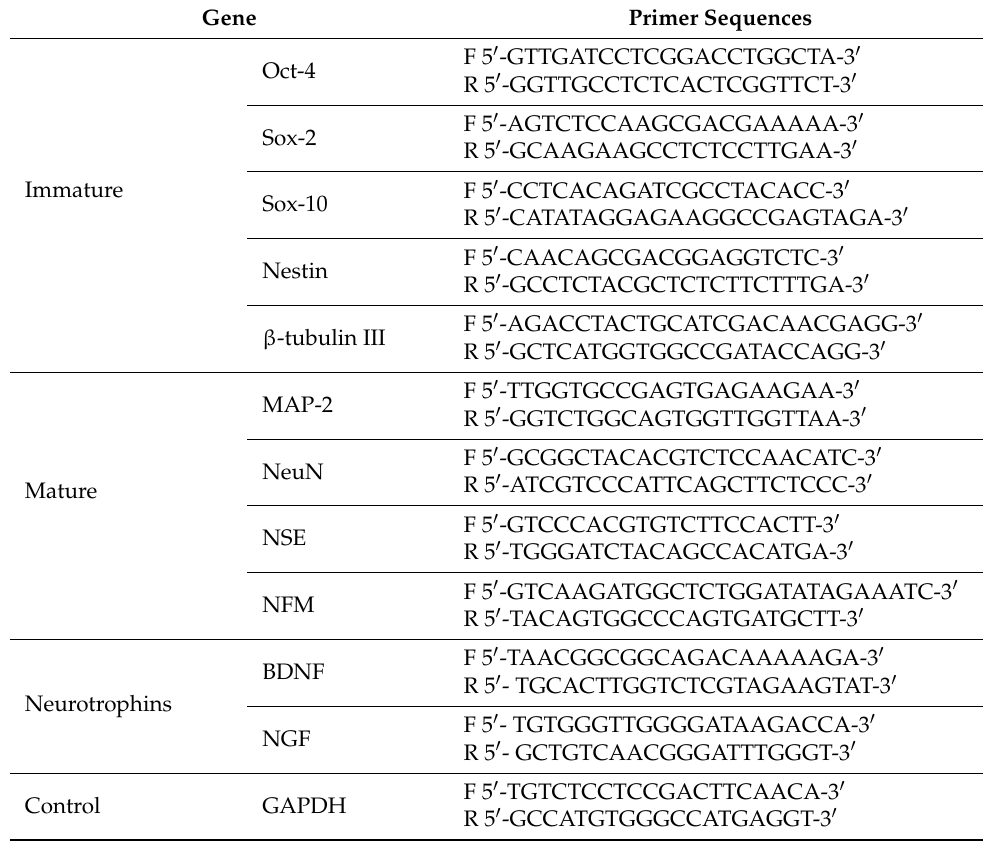
Table 1. RT-qPCR primer sequences